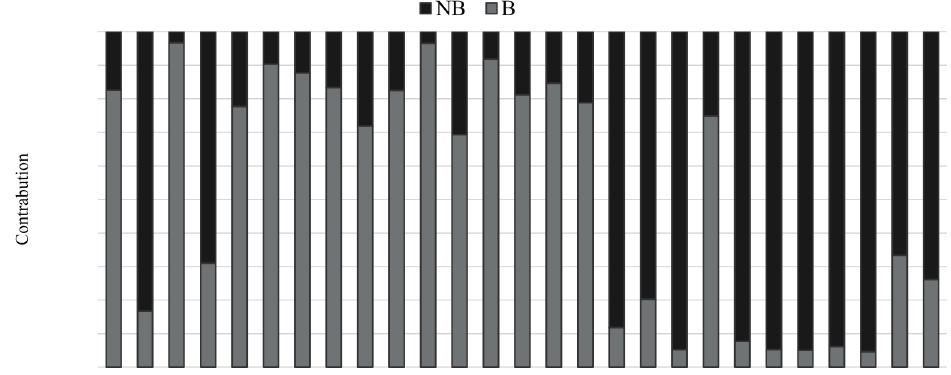
Figure 7. Contribution of carcinogenic PAH compounds to total PAHs in different